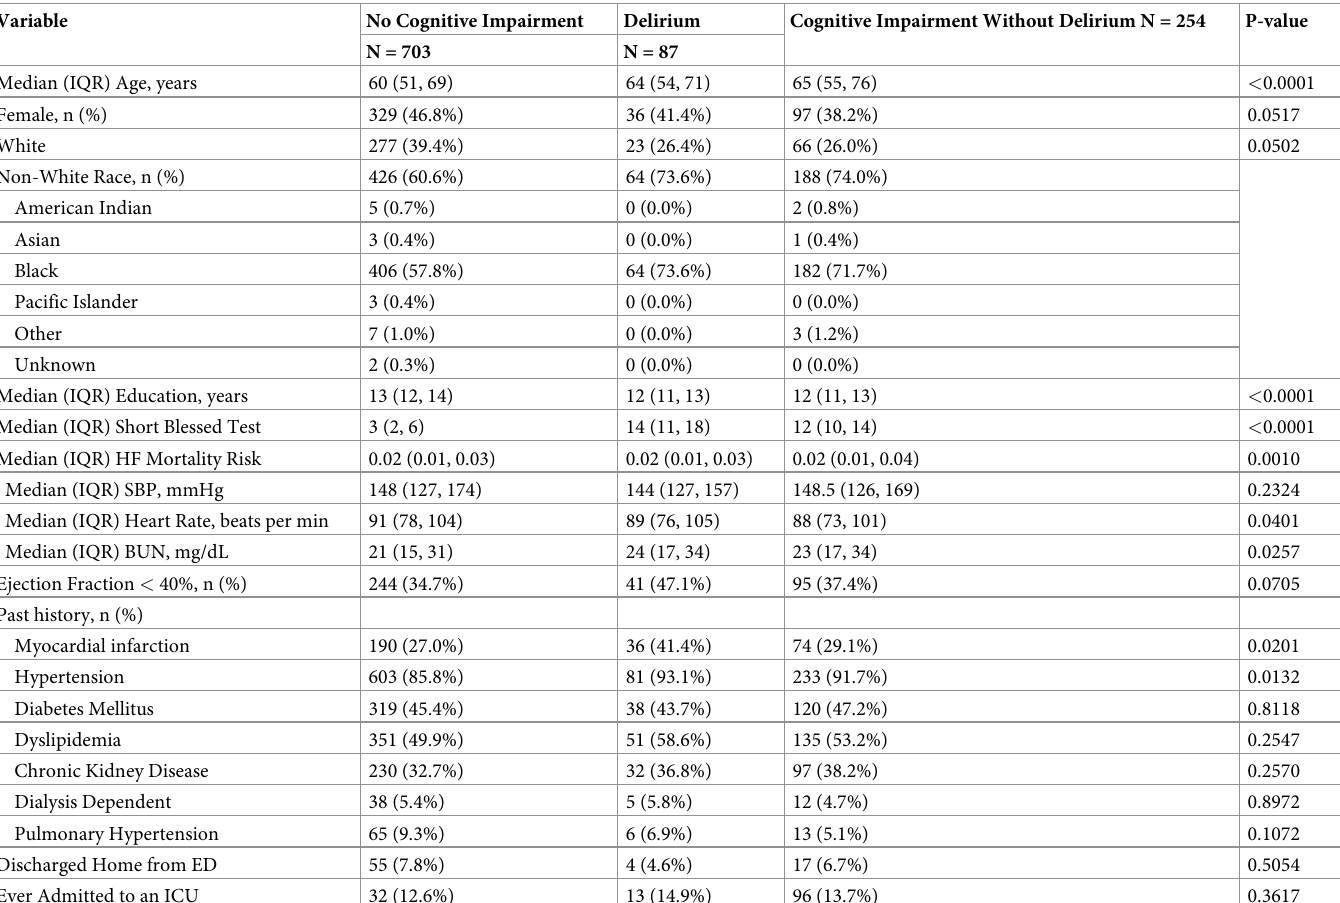
Table 1. Patient characteristics stratified by cognitive impairment status at enrollment. Cognitive impairment was determined by the Short Blessed Test (SBT); a score of 10 or more indicating the presence of cognitive impairment. Heart failure (HF) mortality risk was estimated using age, heart rate, systolic blood pressure, and blood urea nitrogen. Delirium was determined using the brief Confusion Assessment Method (bCAM). IQR, interquartile range; SBP, systolic blood pressure; BUN, blood urea nitrogen; ED, emergency department; ICU, intensive care